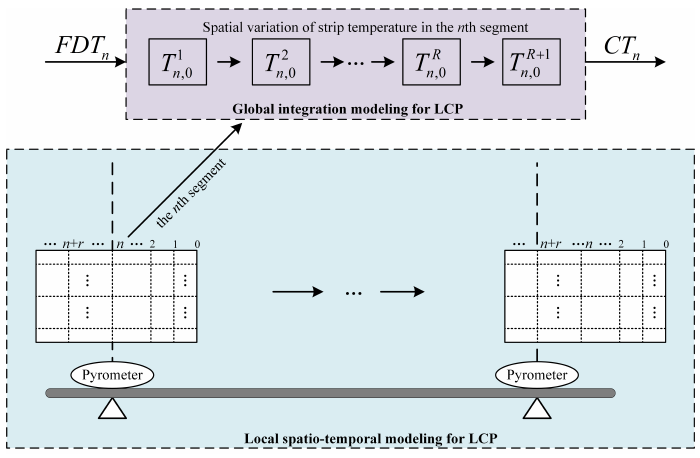
Figure 5. Time–space variation of the strip temperature for